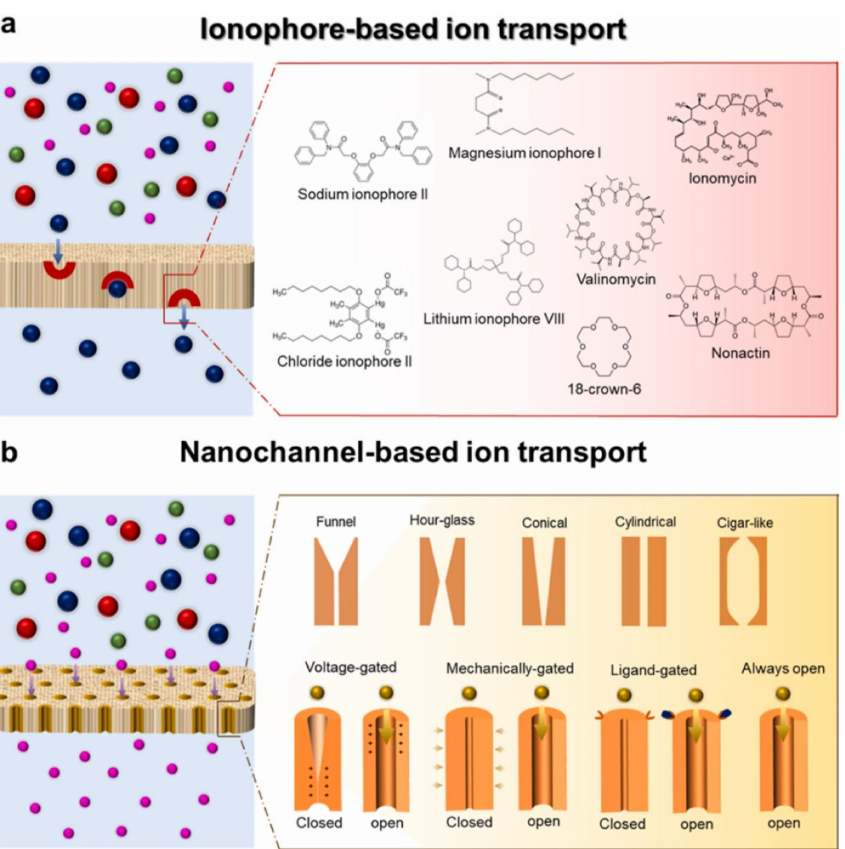
Figure 3. Schematic diagram of two strategies for ion-selective membranes. ( a ) Ionophore-based ion transport; ( b ) nanopores-based ion transport. “Reprinted/adapted with permission from Ref. [51]. 2021, Elsevier”. More details on “Copyright and Licensing” are available via the following link: https://s100.copyright.com/order/cdd17eeb-cdaa-4853-8367-e7224524dafd (accessed on 6 June